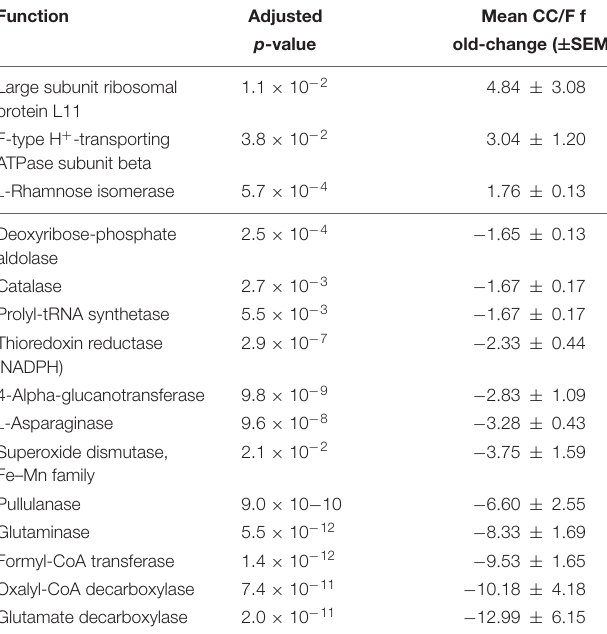
TABLE 2 | Firmicutes functions with significantly differential normalized abundance between cecal and fecal metaproteome. Function